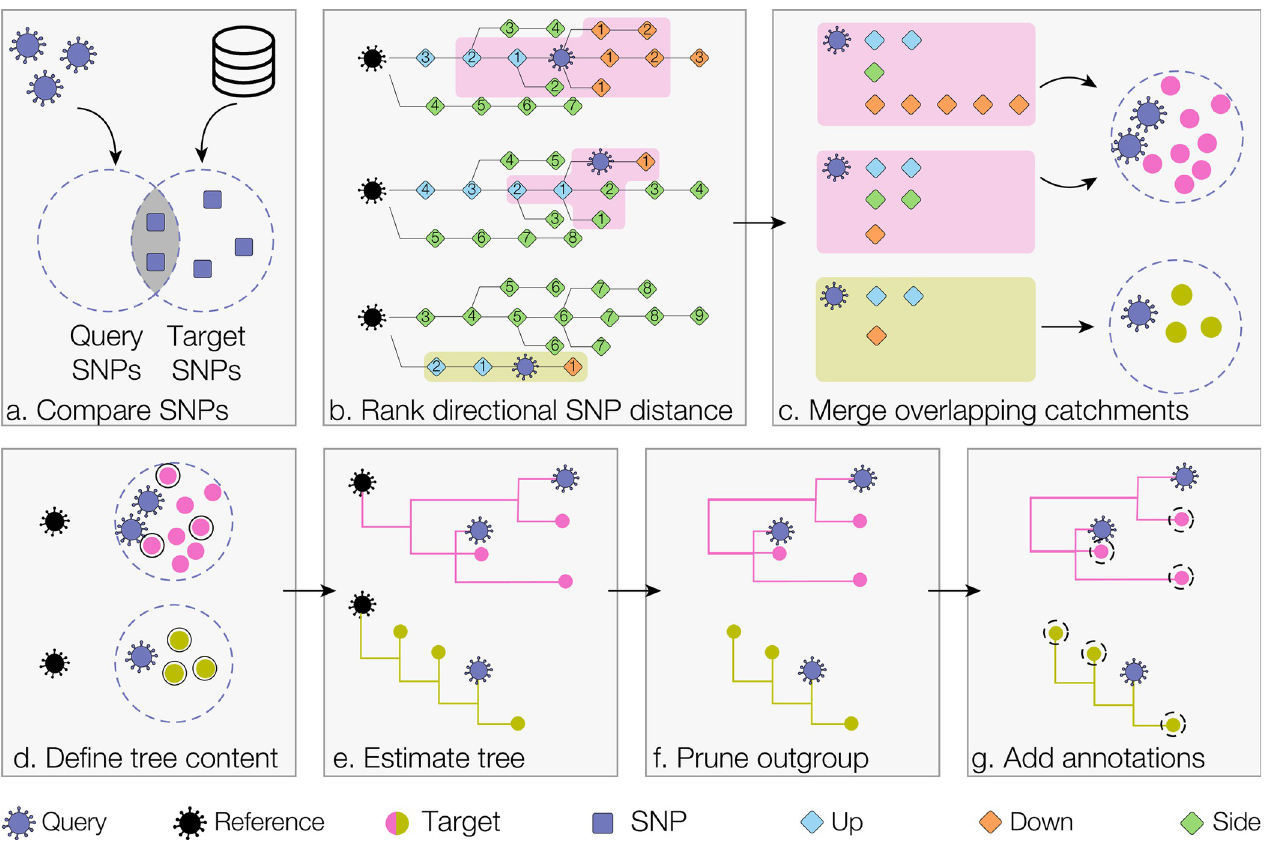
Fig 2. Schema of civet catchment and tree building pipeline. We show three query sequences, falling in two distinct catchments (pink and green). a) Each query sequence is compared against the set of SNPs for every record (target) in the background metadata. By evaluating the intersection and union of the two SNP sets, it is possible to assess directional SNP distance relative to the reference sequence (the early lineage A sequence with GISAID ID EPI_ISL_406801). b) For each query, all targets are ranked by distance from the query and classified as either up, down or side targets based on the set profile in panel a. c) Catchments are constructed by selecting all targets that fall within the specified SNP distance. Up, down and side distances can be configured separately (the default SNP distance of 2 SNPs for all categories is shown here). Civet then merges any catchments with overlapping targets. d) An outgroup reference sequence is added to each catchment and, if necessary, catchments are downsampled. e) Civet estimates a maximum likelihood tree for each catchment using iqtree. f) The reference sequence is pruned out and the tips of the tree are annotated with user-specified fields. g) Specific metadata annotations are added to each tip, which can be toggled within the